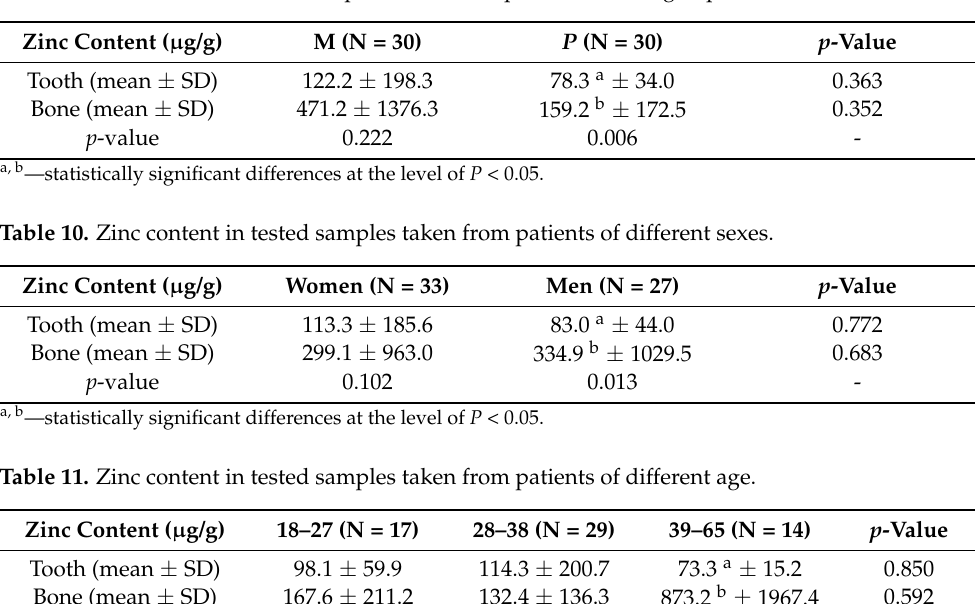
Table 9. Zinc content in tested samples taken from patients differing in place of residence.